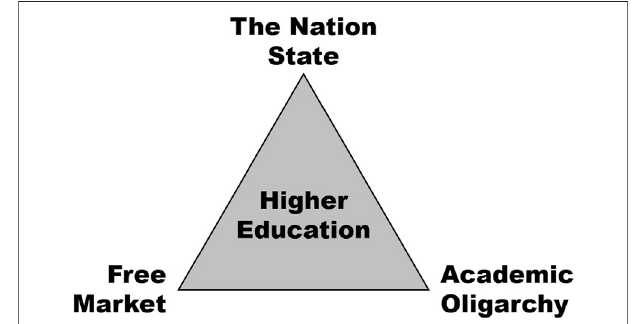
FIGURE 2 | Clark ’ s triangle of forces within higher